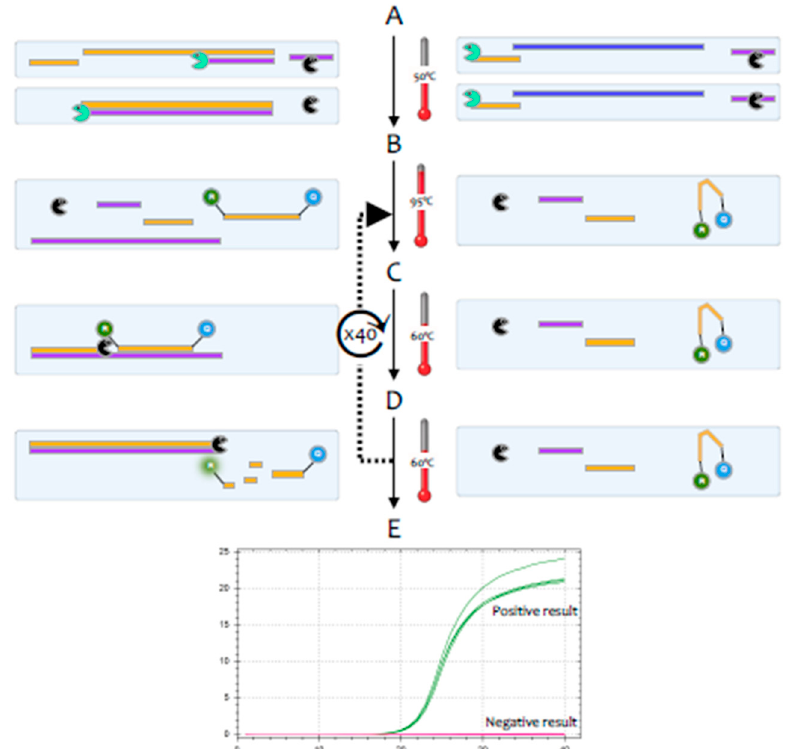
Figure 2. Signal generation during a RT-qPCR test. Test reagents include a buffer, both enzymes, target-specific DNA primers, and a target-specific DNA probe that is labelled at one end with a fluorescent label and at the other with a quencher. Samples on the left and right contain the same primers and probe, but the one on the left harbours target RNA, whereas the one on the right does not. A. RT: Samples are incubated at around 50 ◦ C, which results in the RT transcribing target-specific cDNA from one of the strand-specific primers on the left, with no reverse transcription on the right. B. Denaturation: Samples are heated to 95 ◦ C, which denatures the RNA but leaves the cDNA intact. C. Annealing: the temperature is lowered to around 60 ◦ C, with the actual temperature assay-dependent. This allows both the target-specific primers and probe to bind to their respective targets on the left, whereas primers and probe remain unbound on the right. D. Polymerisation: this step may be combined with the annealing step. On the left, the polymerase extends DNA synthesis, initially from one primer only, but after the first cycle from both, and displaces and hydrolyses any bound probe. This separates fluorophore and quencher and results in the emission of light if the fluorophore is excited at the appropriate wavelength. On the right, none of this occurs, and no light is emitted. This first cycle is followed by a further, user-defined number of cycles, indicated by the stippled arrow leading back to step B. E. Amplification plots obtained for each sample track the increasing emission of light characteristic of a positive result from the sample on the left (green plot), whereas the sample with no amplifiable target on the right records no light emission and a negative result (red